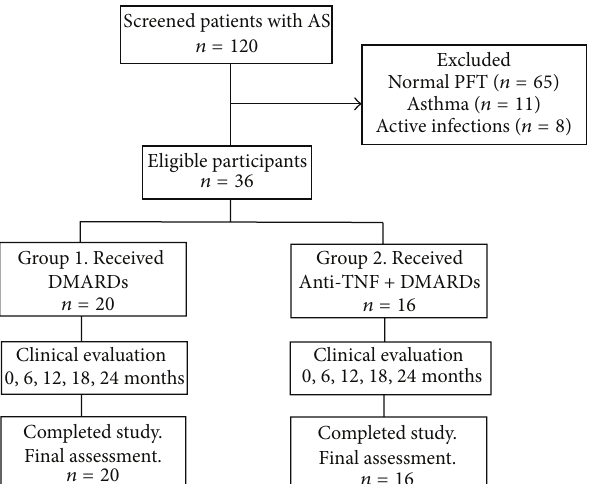
Figure 1: Flowchart of the patients during the cohort. AS, ankylosing spondylitis; LFT, lung function test; DMARDs, disease modifying antirheumatic